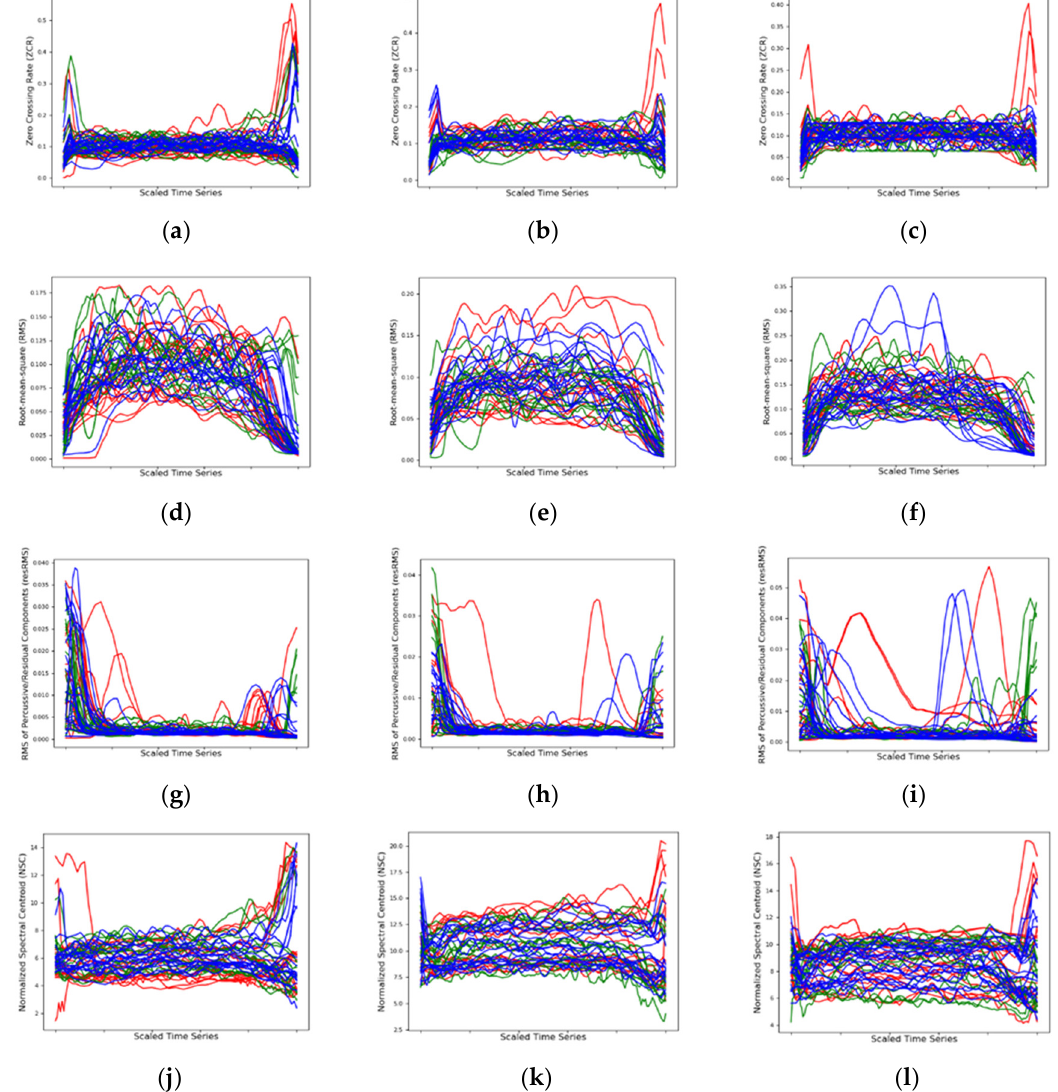
Figure 7. Time-varying descriptions registers for ZCR (( a ) low, ( b ) mid, ( c ) high); RMS (( d ) low, ( e ) mid, ( f ) high); resRMS (( g ) low, ( h ) mid, ( i ) high); NSC (( j ) low, ( k ) mid, ( l ) high). Red Line — Hawley appliance central incisors (HACI), Green Line — TEATA, Blue Line — Customized Splint. The time series of all plotted sounds were scaled on the x-axis to uniform duration.